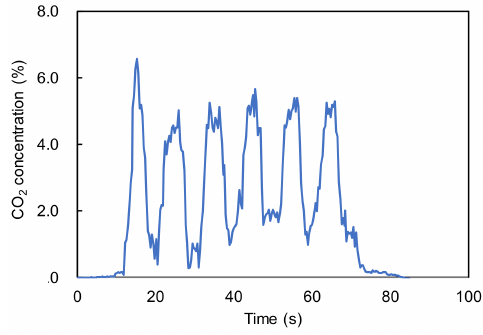
Figure 11. Change in the CO 2 concentration measured inside a